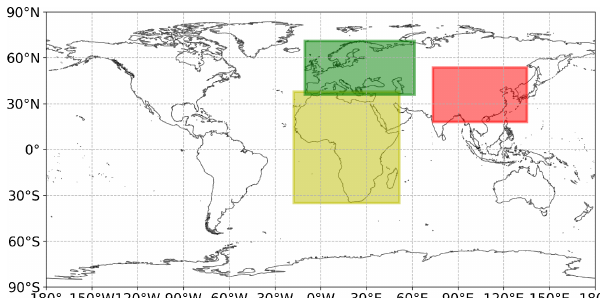
Figure 1. Overview of the investigated regions Europe (green), Africa (yellow), and China (red) included in this